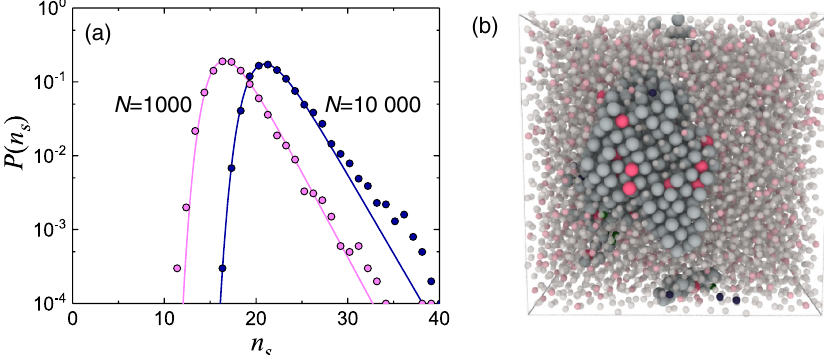
FIG. 5. Crystal nucleation in CuZr. (a) Compositional fluctuations of majority Zr atoms in Cu 25 Zr 75 at T ¼ 1500 K. Lines are fits to a Gumbel distribution. (b) Nucleus in the early stage for Cu 25 Zr 75 at T ¼ 900 K. Large gray particles are Zr (bcc), large pink are Cu (bcc), smaller gray and pink are liquid Zr and Cu, respectively, and black are Zr in a local fcc environment as determined with bond- orientational order parameter [25]. We see that the nucleus is dominated by